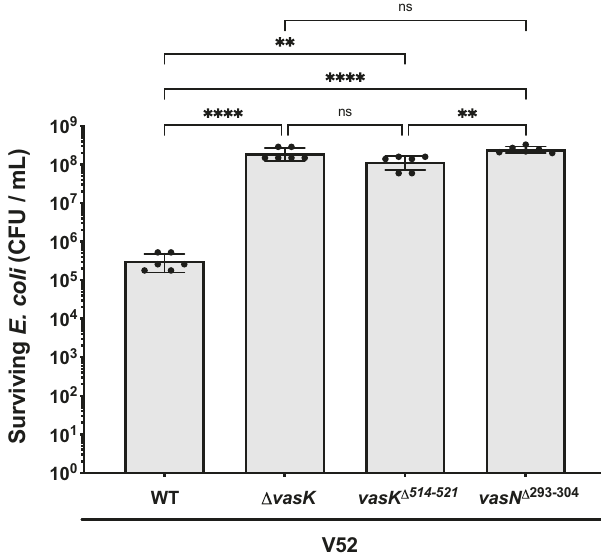
Fig. 2 Classical alleles of vasK and vasN disable the T6SS. A deletion within vasN present in 2nd and 6th pandemic strains, or a deletion in vasK found in 6th pandemic strains were constructed in V. cholerae V52. Strains were assayed for killing E. coli MG1655 to determine T6SS function. Wild- type V52 was used as the positive control and V52 Δ vasK as the negative control. Killing assays were performed for 4 h at 37 °C. Mean± standard deviation of n = 3 biologically independent experiments, each performed in duplicate, is shown. Horizontal bars represent the mean and error bars represent the standard deviation. Statistical signi fi cance was determined by ordinary one-way ANOVA with Tukey ’ s multiple comparisons test (**** p < 0.0001, ** p = (0.0024, 0.0014), ns = not signi fi cant). Source data are provided as a Source Data fi